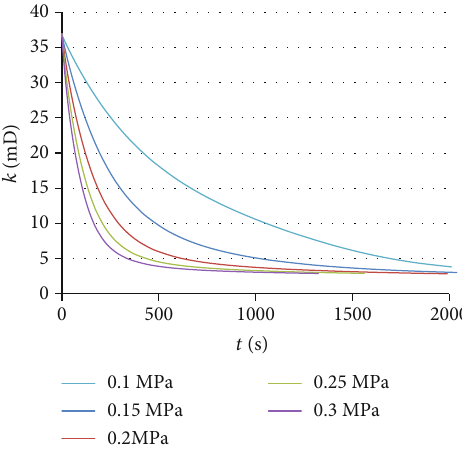
Figure 17: Variation curves of permeability of coal samples under di ff erent grouting